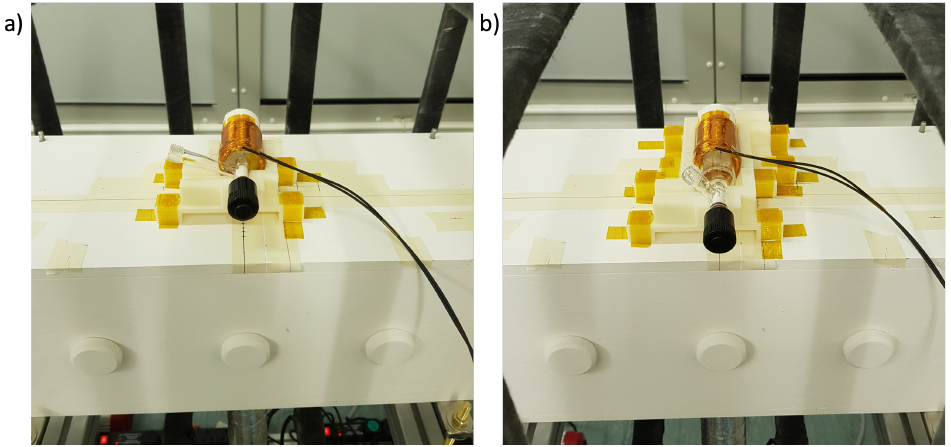
Figure A3. 129 Xe polarimetry setups with each container containing Xe gas mixture inside a solenoid coil, placed on the 3D printed stand(s). ( a ) Spherical container setup, ( b ) Cylindrical container setup. Two sampling containers were used. A spherical (diameter = 23.9 mm) container was initially used which was positioned within the homogeneous region of the